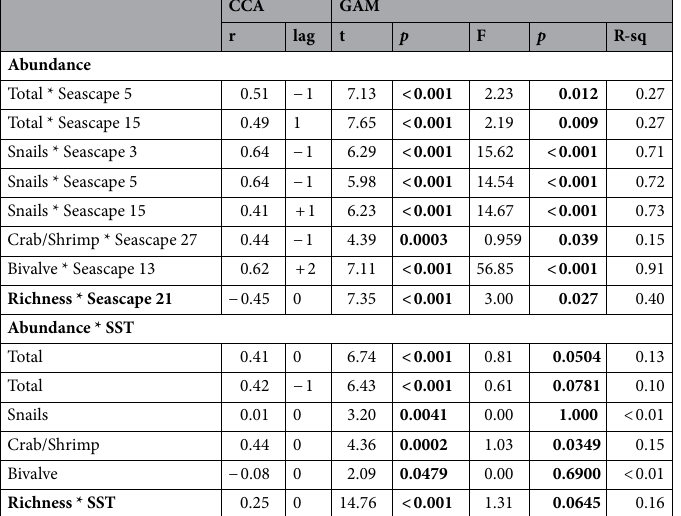
Table 3. Significant results of the cross-correlation analysis (CCA) comparing recruitment and Seascape variability (% Cover) and correspondent generalized additive models (GAM). r is the correlation coefficient; lag is the time lag (months); t and F for statistic, R-sq for adjusted R-squared, and D.Exp for % deviance explained by the model. Significant results (p < 0.05) are in bold. See Supplementary Table S7 in Supplementary material for full CCA